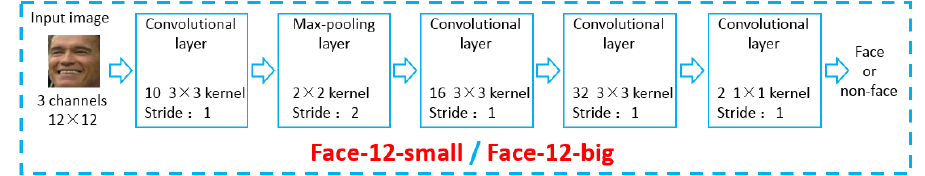
Figure 3. The CNN structure of Face-12-small and Face-12-big.